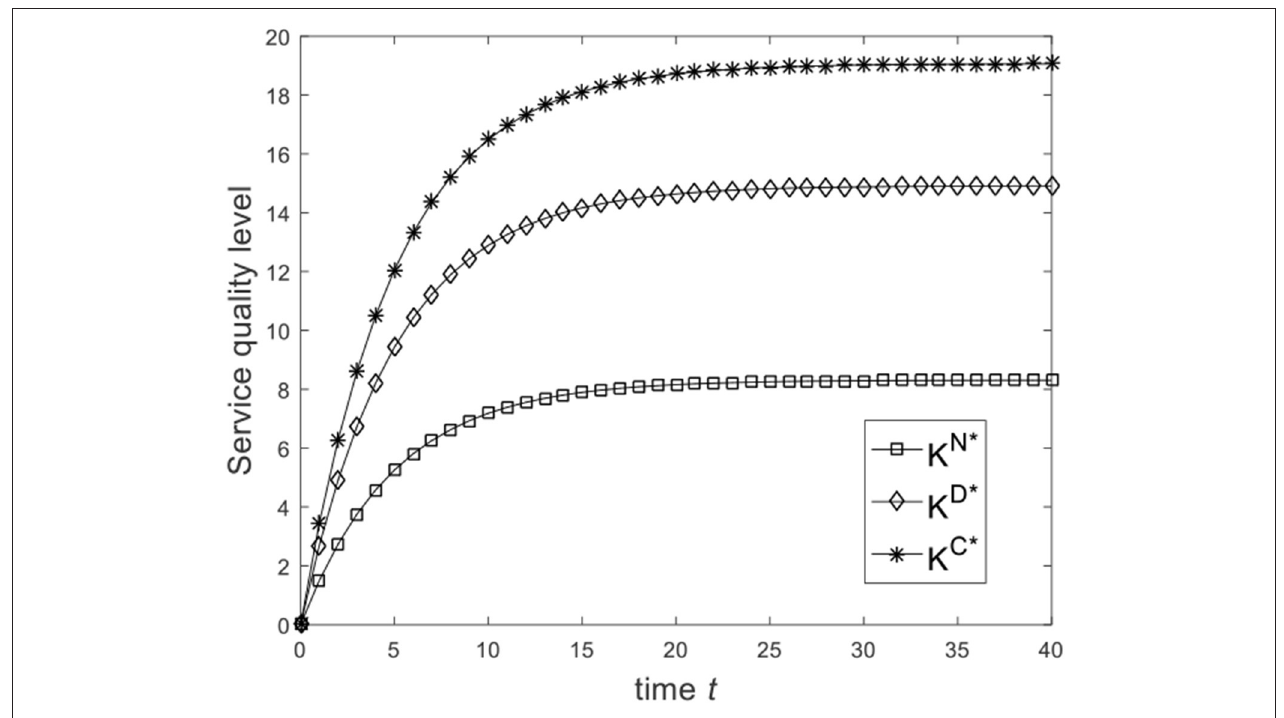
FIGURE 1 | Diagram of enterprise service quality level for ω